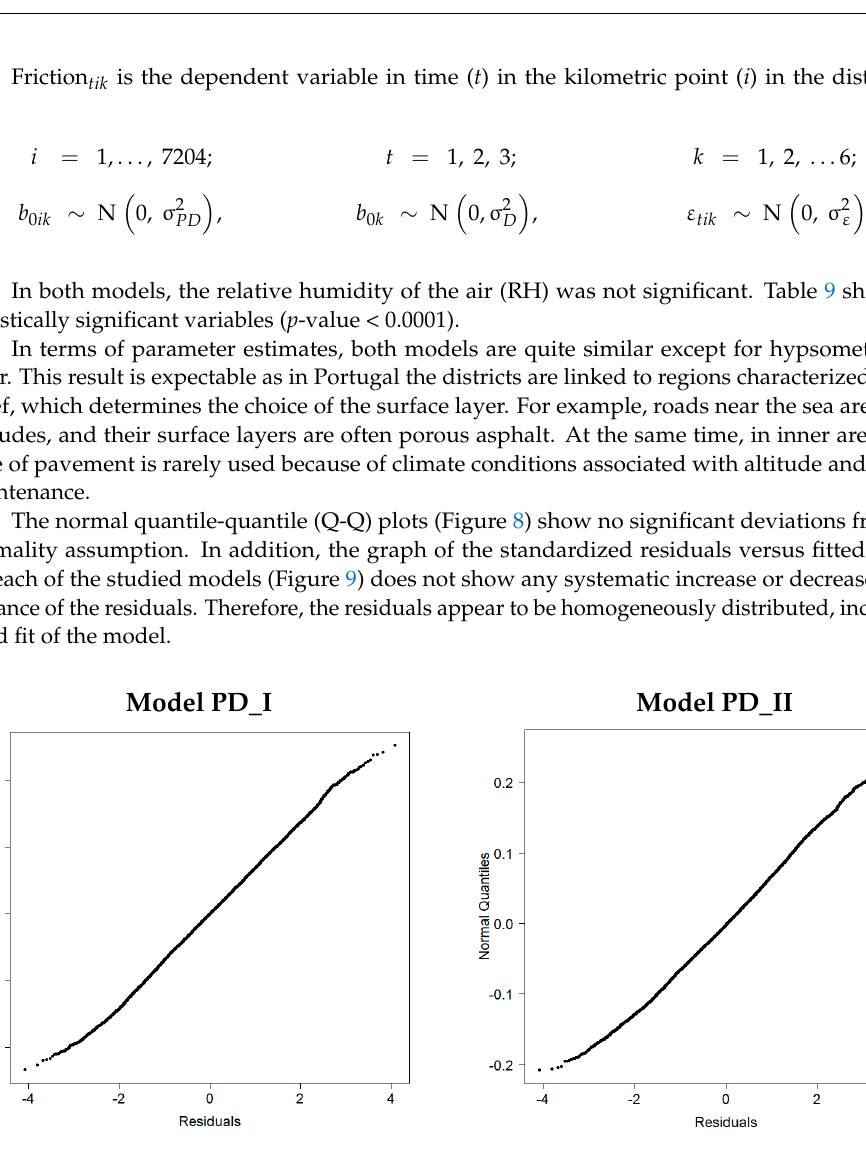
Figure 8. Normal Q-Q plot of the standardized residuals from Models PD_I and II.